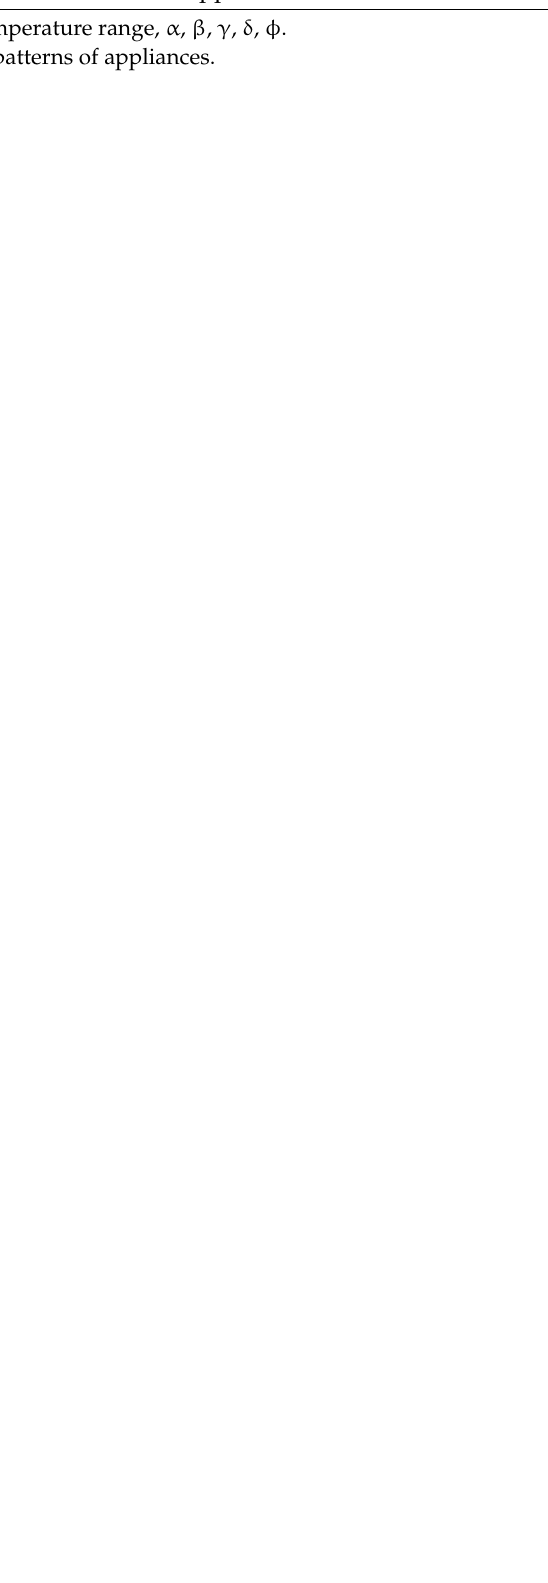
Algorithm 1 Pseudo code of the proposed algorithms for tc and ua